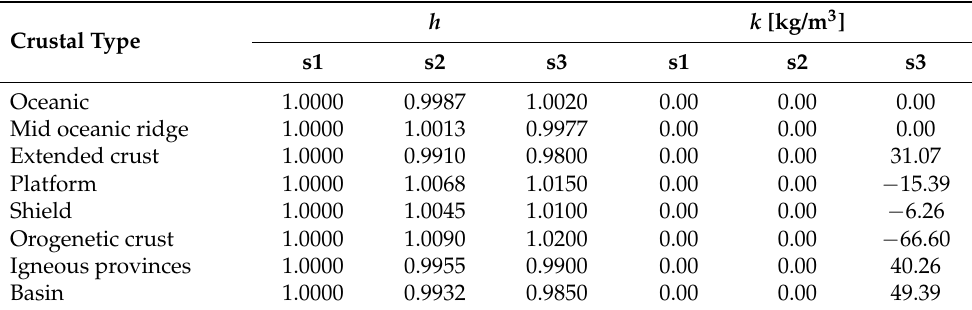
Table 1. “True” scale factors ( h ) and biases ( k ) chosen in the three different scenarios for all the provinces belonging to the same crustal type.